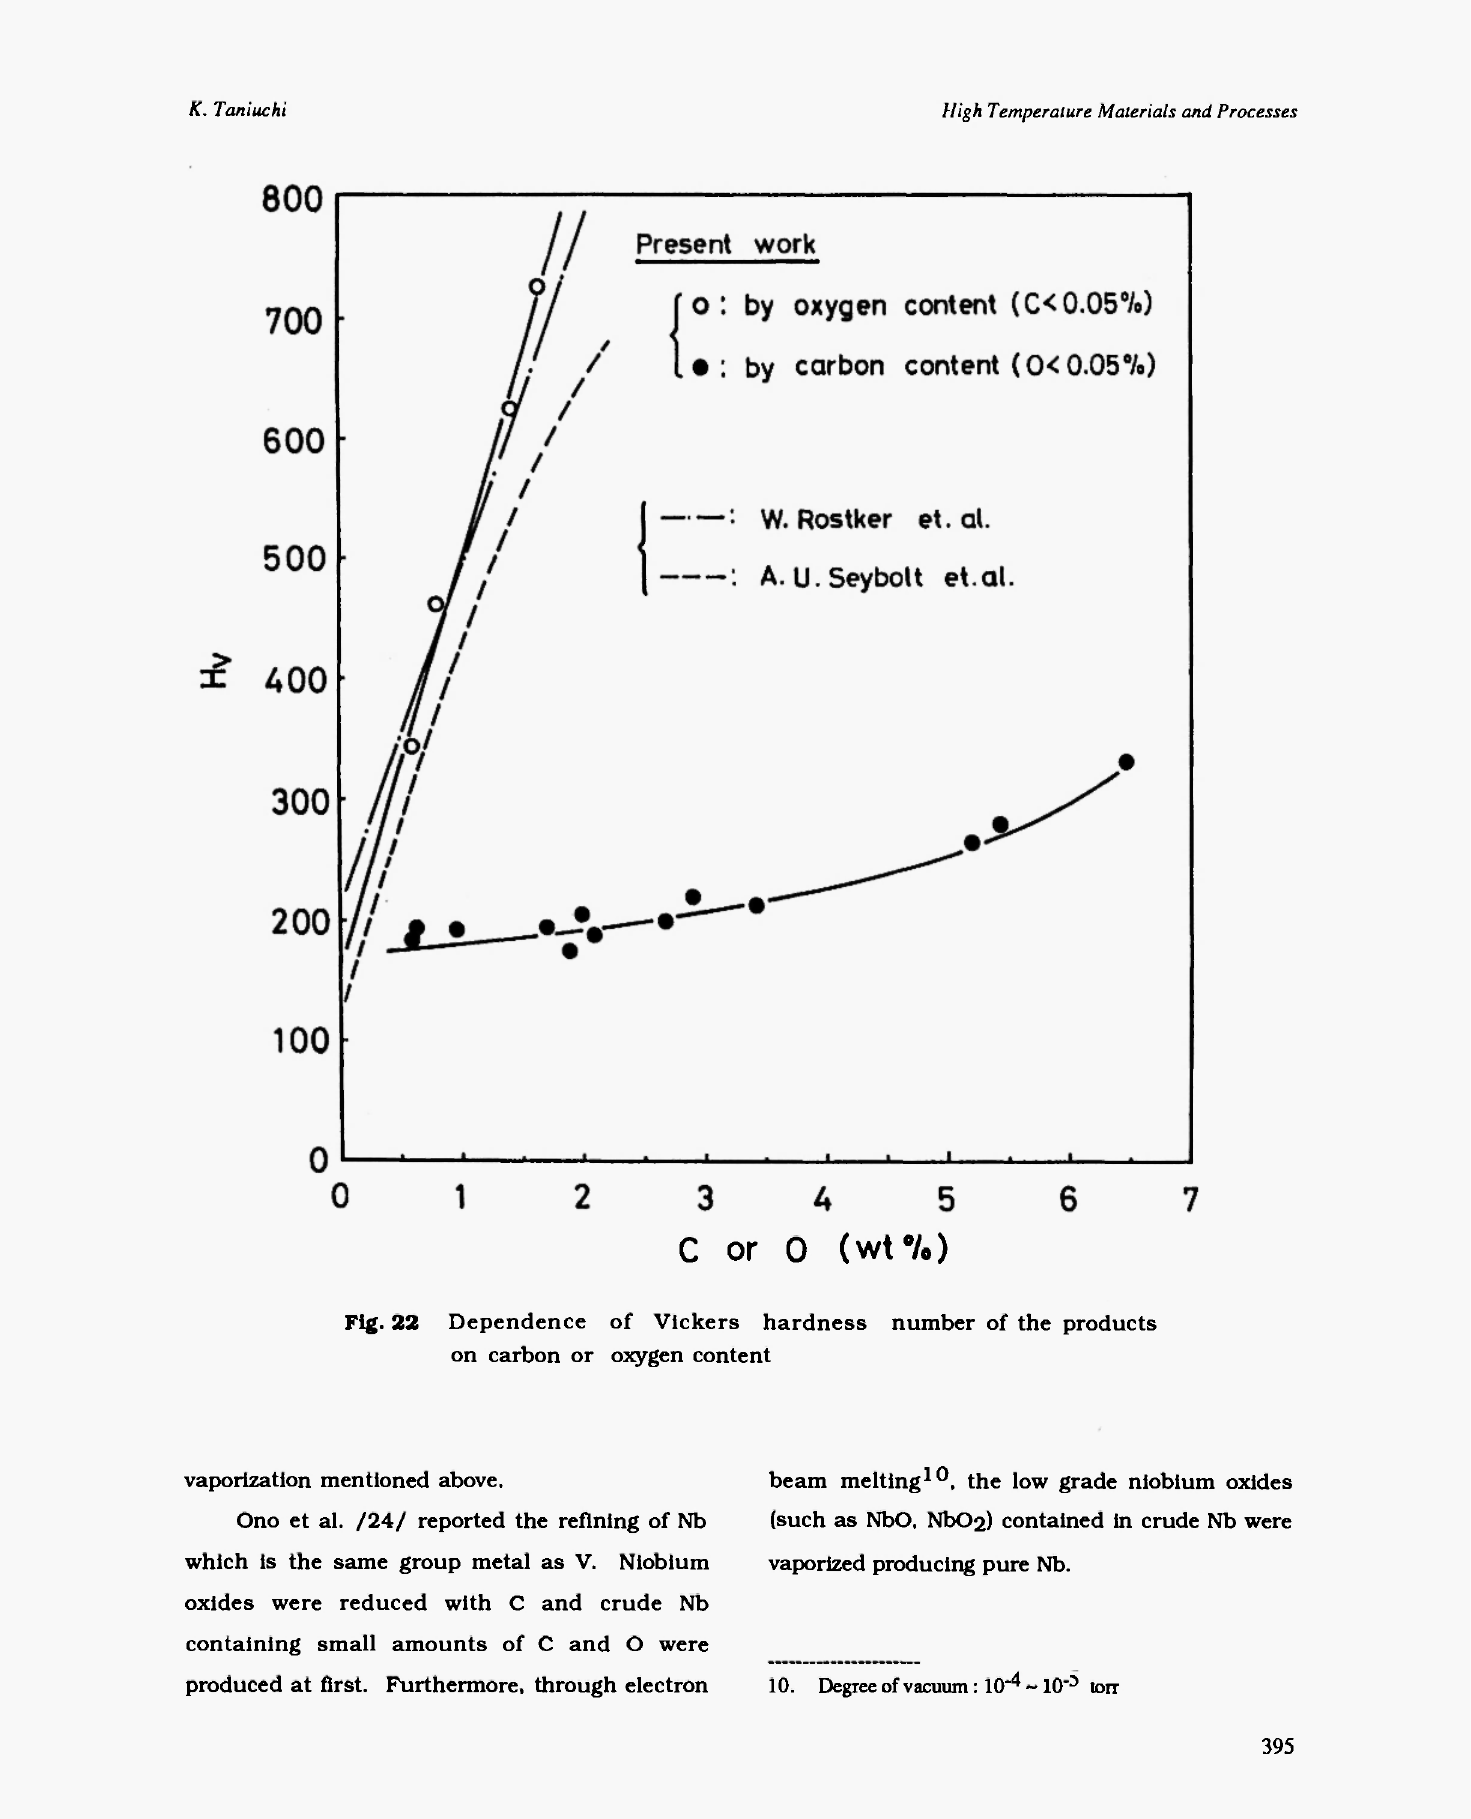
or °lo) Fig. 22 Dependence of Vickers hardness number of the products on carbon or oxygen